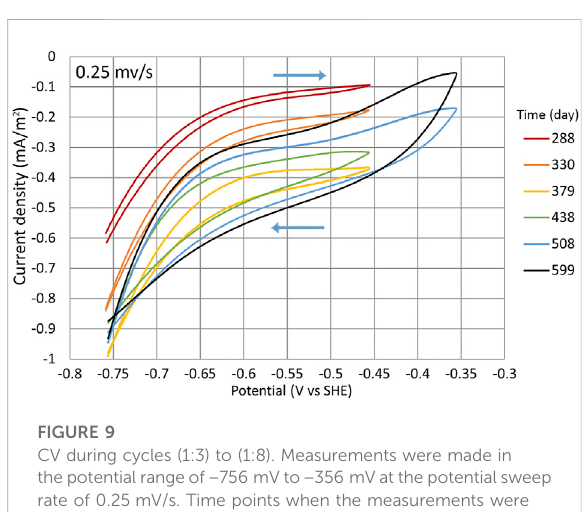
FIGURE 8 Average abundances of gene copies on WE and CE over all three electrode sets on a logarithmic scale. 16S rRNA , nirK , amoA bac, nirS , nosZI ,andcomammoxgeneabundancesareshown.See chapter 3.5 for the explanation of gene symbols. Error bars are used to show the standard error.